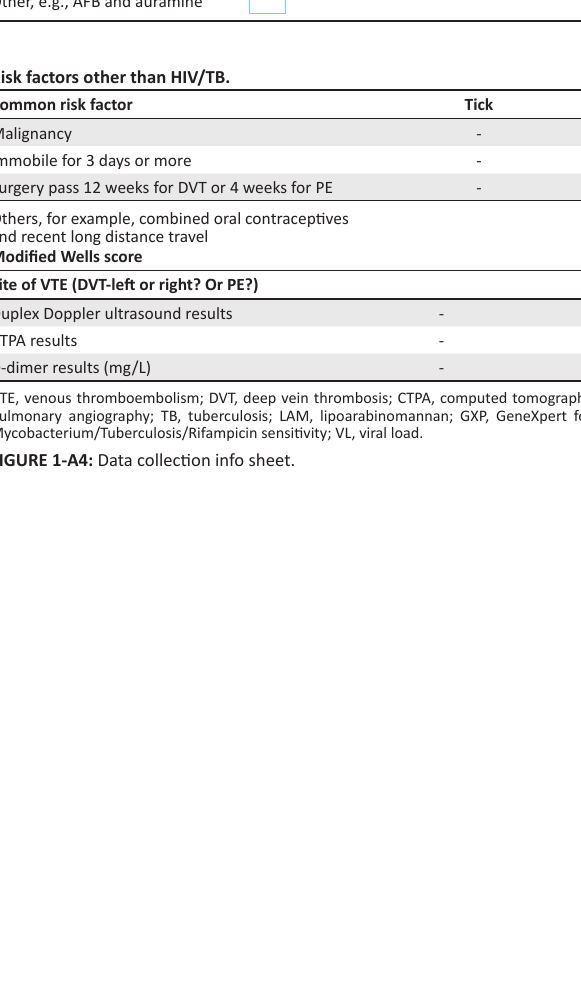
FIGURE 1-A5: Diagnostic algorithm for suspected venous thromboembolism with adjusted modified Wells score for